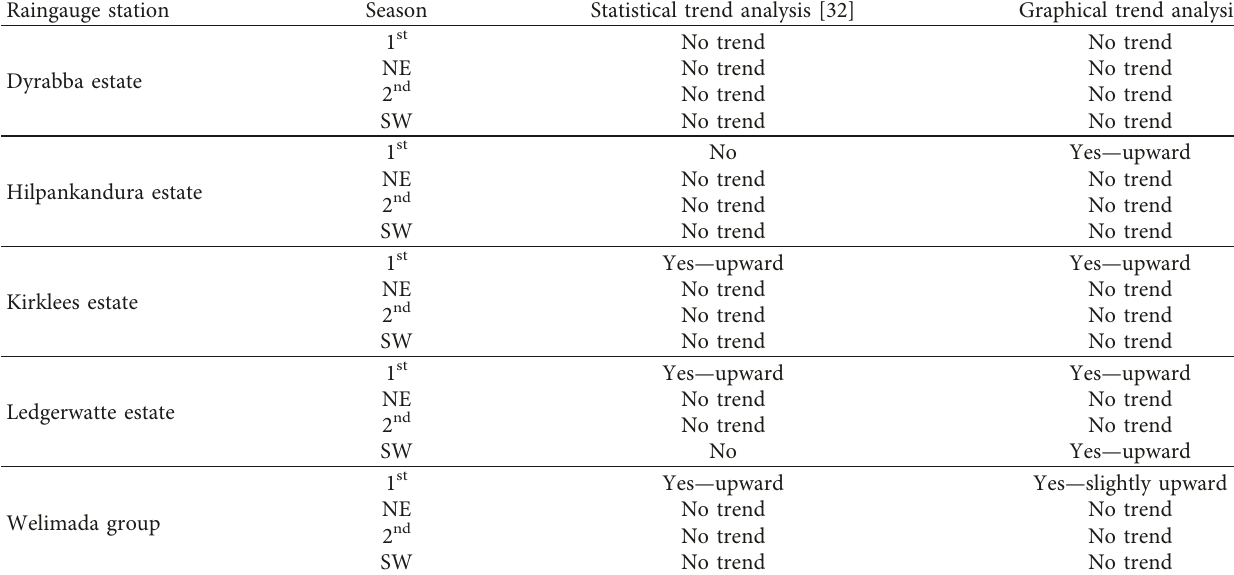
Table 3: Comparison results for seasonal rainfalls for Uma Oya catchment.